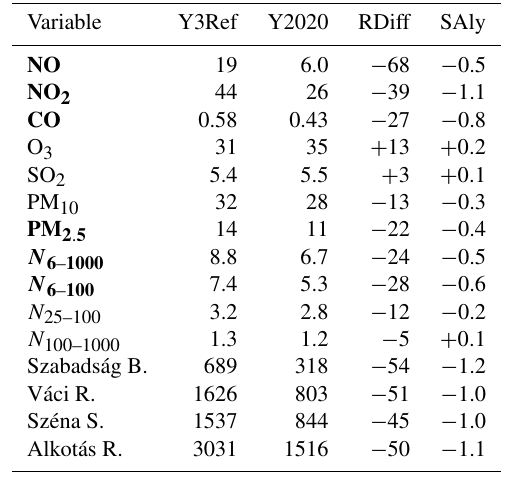
Table 5. Median atmospheric concentrations of NO, NO 2 (both in units of µgm − 3 ), CO (mgm − 3 ), O 3 , SO 2 , PM 10 mass, PM 2 . 5 mass (all in µgm − 3 ), N 6–1000 , N 6–100 , N 25–100 , N 100–1000 (all in 10 3 cm − 3 ) and median vehicle road traffic (h − 1 ) on Szabadság